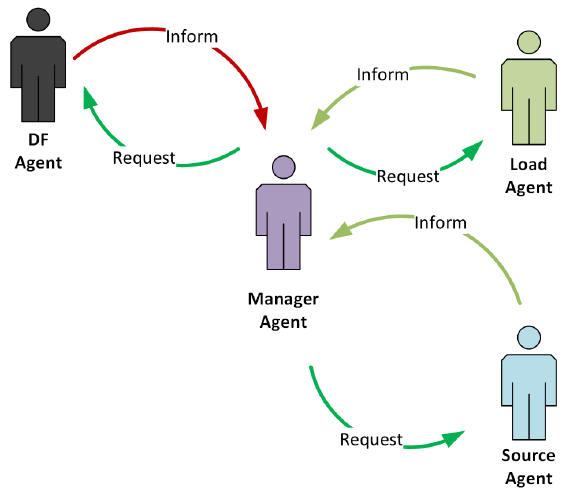
Figure 7. Data Exchange updated in MAS.